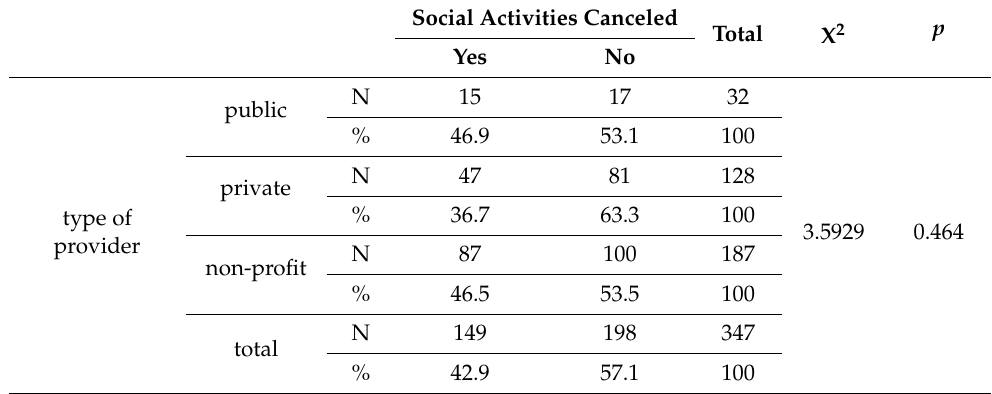
Table 2. Association between structural characteristics and social activities for PLWD being